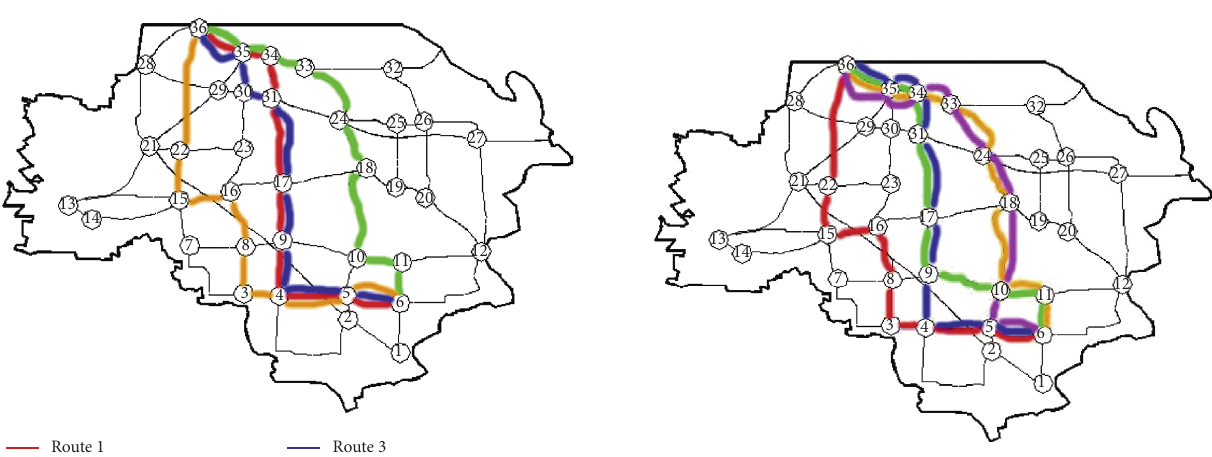
Figure 10: Pareto nondominated solutions between nodes starting at 5:00. Figure